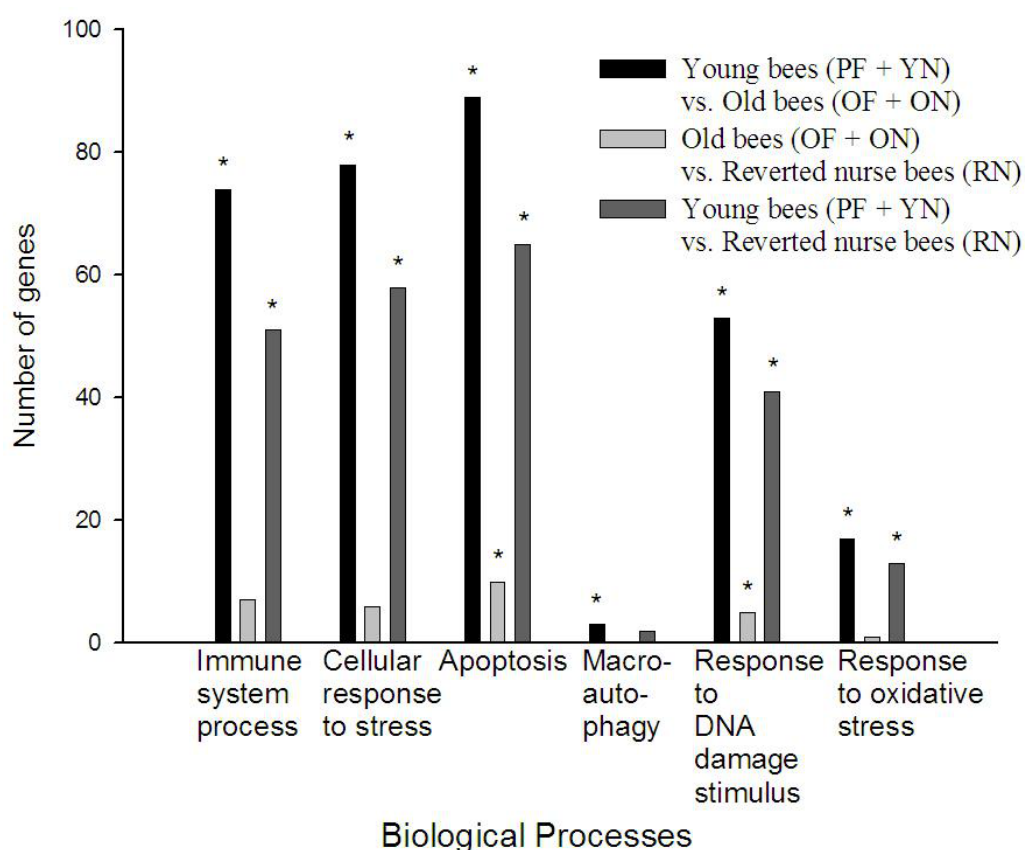
Figure 4. Comparison of biological processes. Gene ontology analysis revealed a series of biological processes involved in immune function and aging/senescence that were enriched in each comparison. The x-axis represents the number of genes differentially expressed for the biological processes represented on the y-axis. Stars represent a Fisher p-value